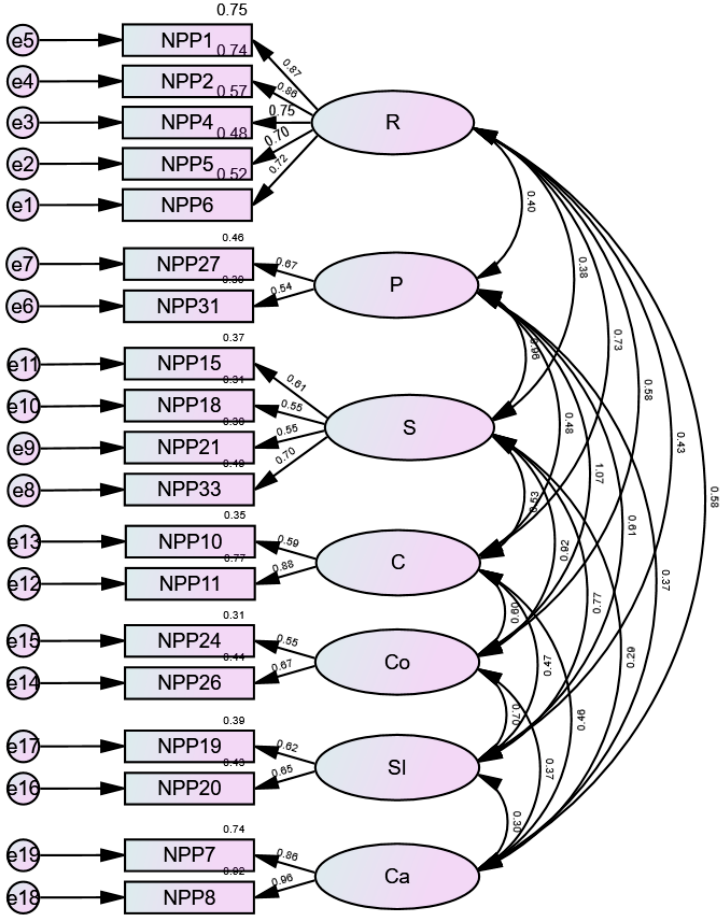
Figure 1. The measurement model for the Pediatric Nurse Parent Partnership Scale-Pediatric Nurse. R: Reciprocity; P: Professional Knowledge and skill; S: Sensitivity; C: Collab-